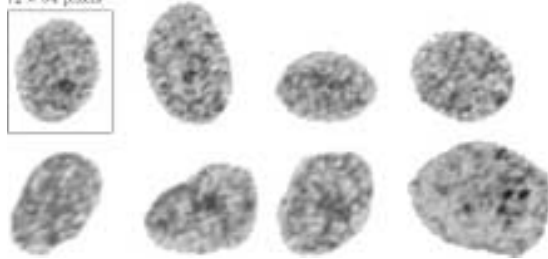
Fig. 1. Four cell nuclei from a good prognosis sample (upper) and four nuclei from a bad prognosis sample (lower). The nuclei were selected from monolayers.